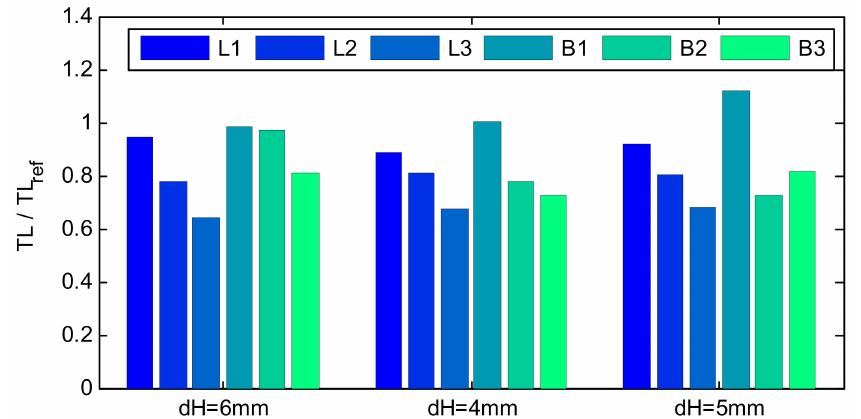
Figure 6. Experimental toe length ratios ( TL/TL ref ) for comparison of heterogeneous cases to the homogeneous reference case for dH = 6 mm, 4 mm, and 5